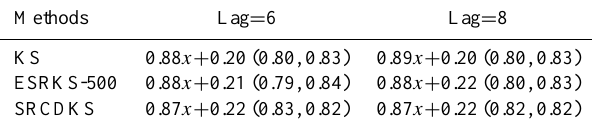
Table 1. Inversion results using different lag lengths without tak- ing correlations into account. All statistics are tested for statisti- cal significance with p < 0 . 001. The first value in the brackets is the root mean square error of the inversion; the second value is the R 2 value of the linear regression. The regressions are the posterior fluxes against the true fluxes. The SRCDKS is implemented with the reduced set of sigma points chosen using the PCA method. No interval constraint is imposed for the inversions.